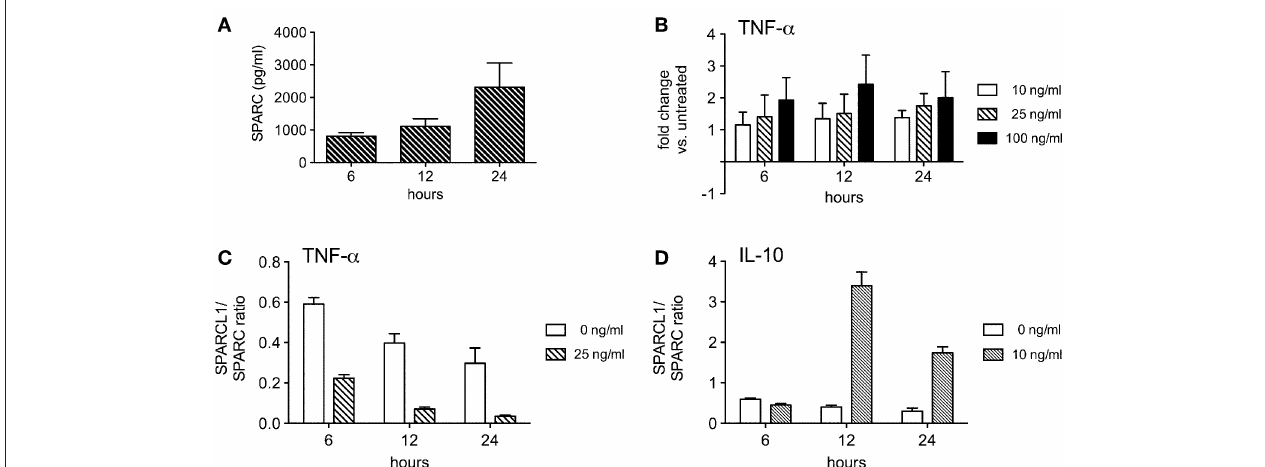
FIGURE 7 | Some T cell-derived cytokines regulate astrocyte production of SPARC in vitro. (A) Astrocytes spontaneously secrete measurable amounts of SPARC into culture supernatants ( n = 4 experimental replicates per time point). (B) TNF- α modestly induces astrocyte SPARC production ( n = 3 experimental replicates per time point). (C) TNF- α suppresses the ratio of SPARCL1 to SPARC made by astrocytes over time, p < 0.0001 comparing ratio differences, p = 0.0002 comparing changes over time. (D) IL-10 augments the ratio of SPARCL1 to SPARC made by astrocytes over time, p < 0.0001 comparing ratio differences, p < 0.0001 comparing changes over